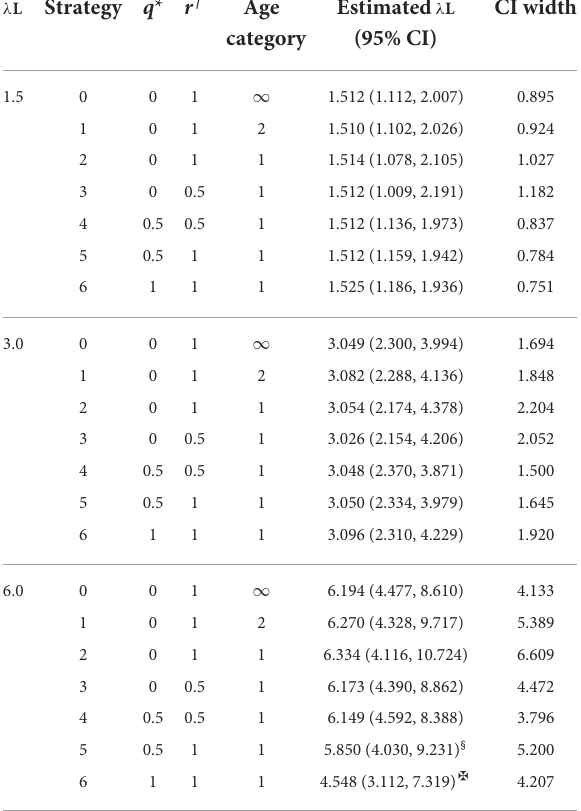
TABLE 3 Estimated values of λ L and their 95% CIs for seven sampling